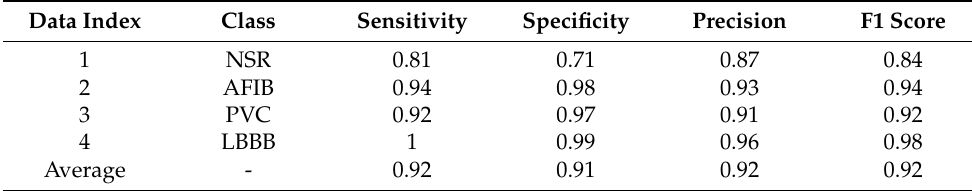
Table 2. Algorithm performance evaluation results.